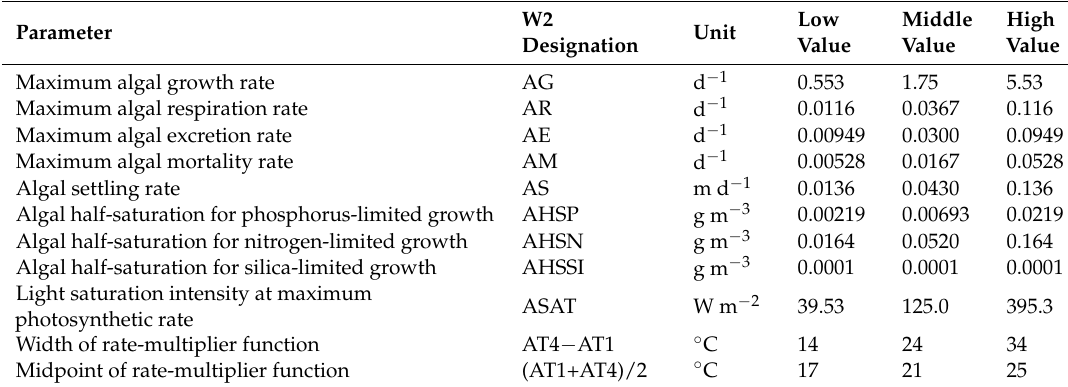
Table 2. Algal growth parameters and levels tested via full-factorial